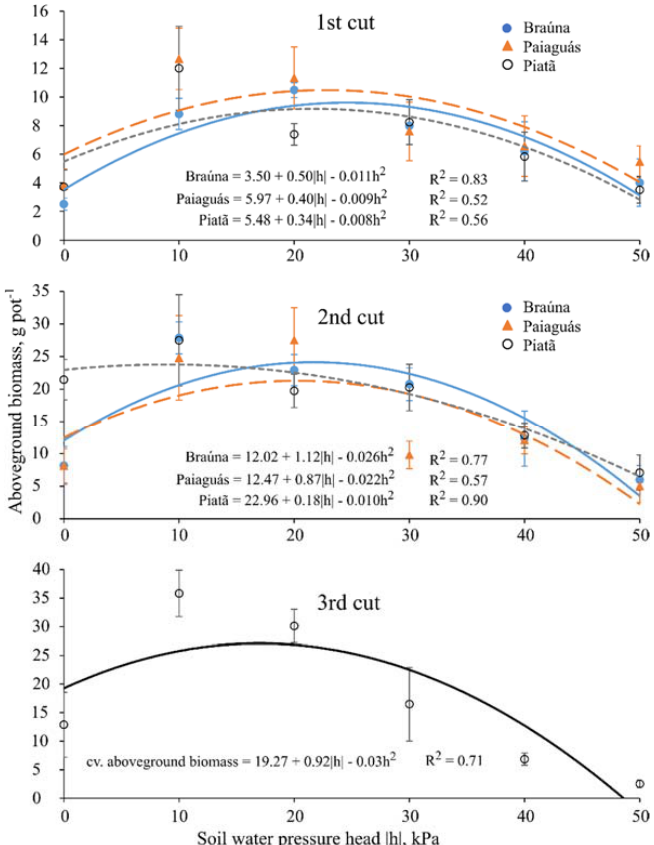
Figure 6. Regression models relating soil water pressure head to aboveground dry biomass of Brachiaria brizantha cultivars for the three cutting periods (40, 70, and 100 DAE). Error bars correspond to the standard deviation of the four replicas.